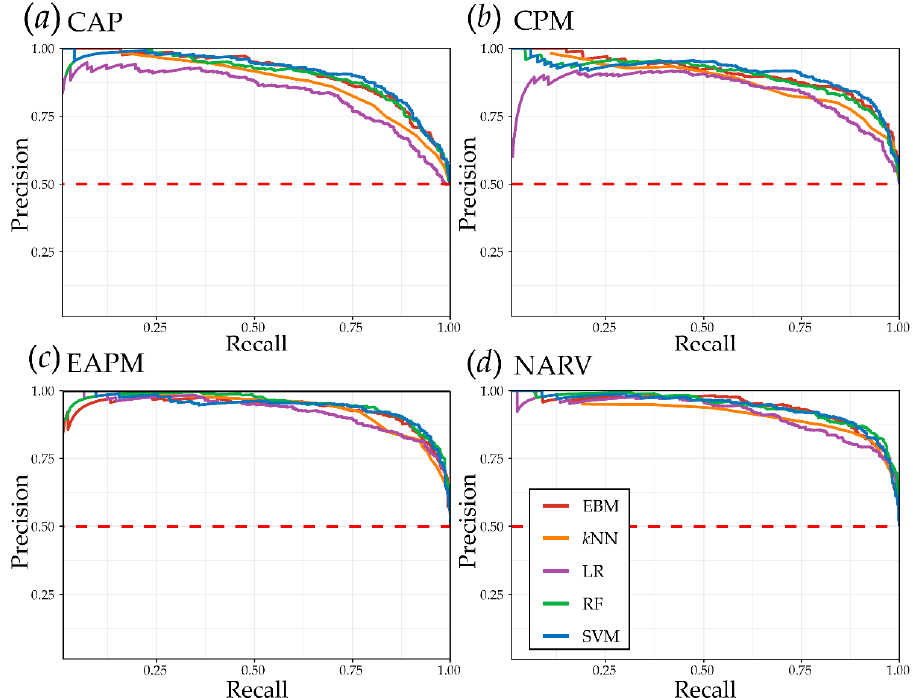
Figure 6. Precision-recall (PR) curves for all five models in each of the four MLRA study areas. Associated AUC PR values are provided in Table 4. ( a – d ) provide results for the CAP, CPM, EAPM, and NARV MLRAs, respectively.